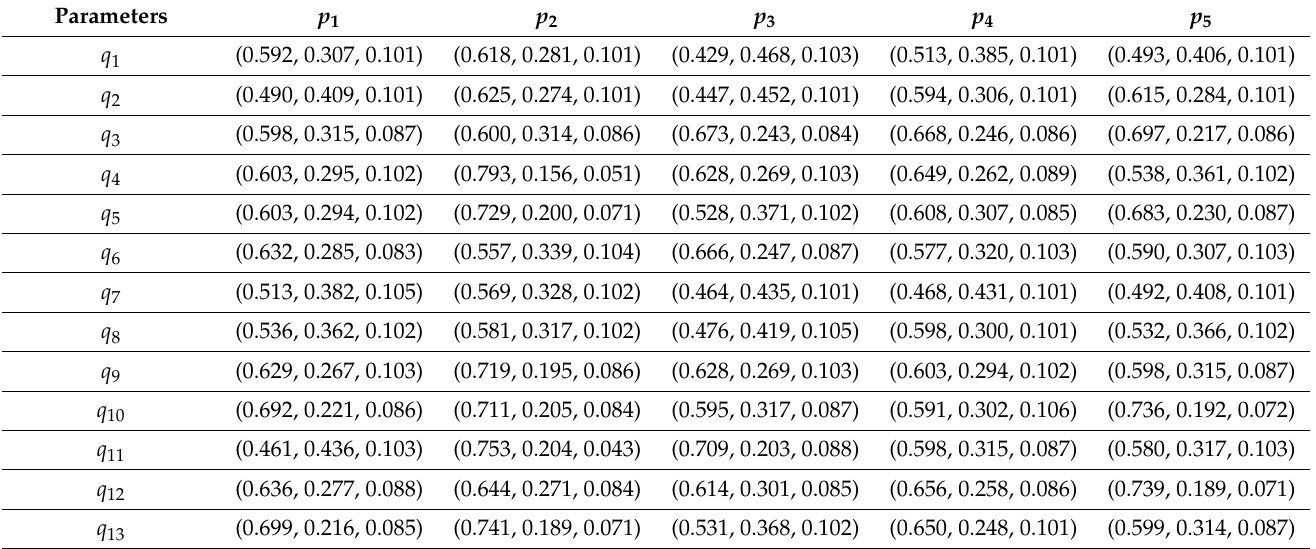
Table A3. The normalized AIF-DM of each option for prioritizing the BESSs.